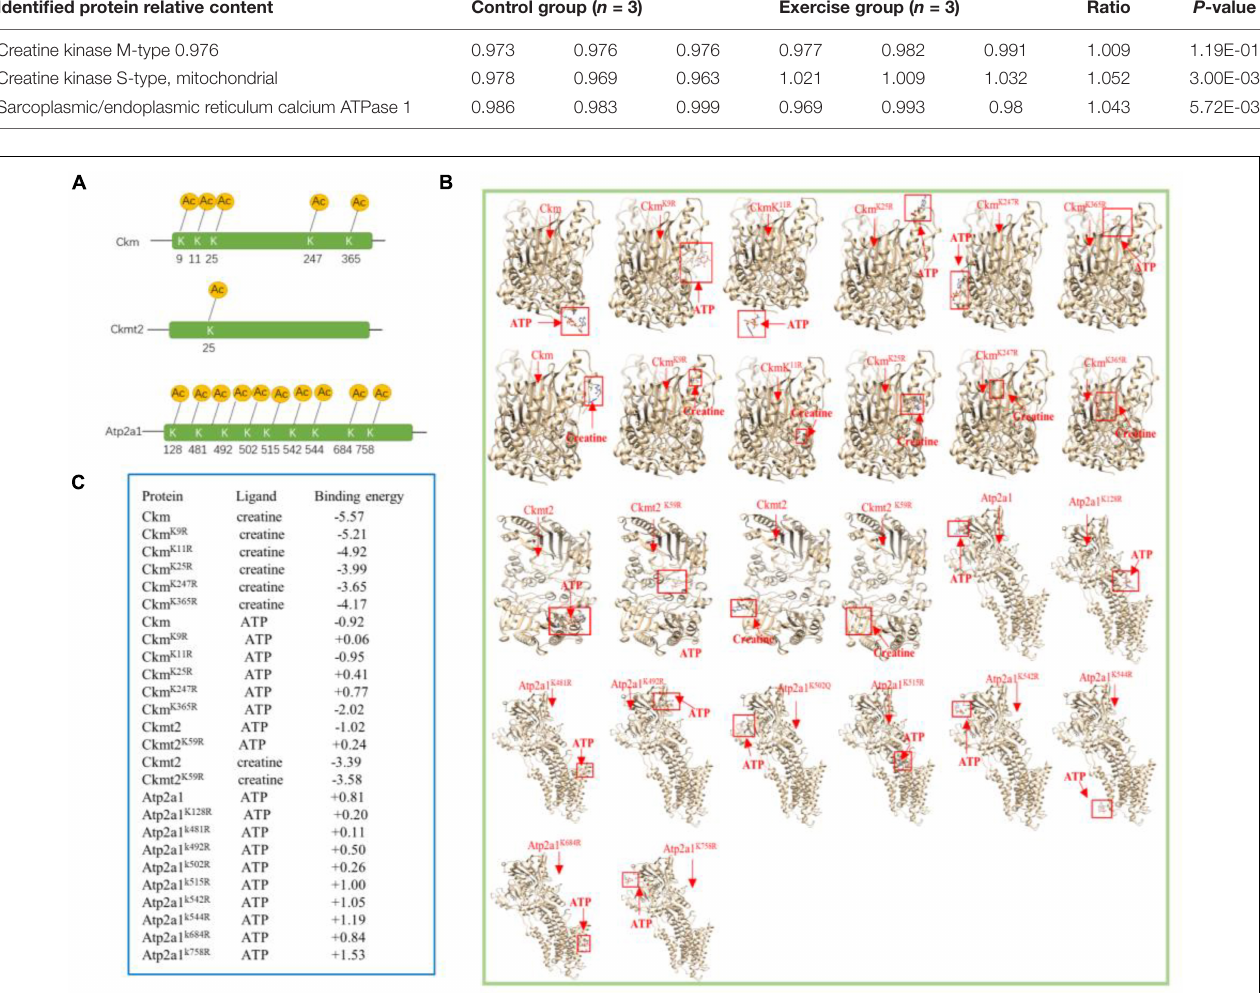
FIGURE 5 | Molecular docking analysis of enzymes. (A) Localizations of the multiacetylated sites in three enzymes that were identified with 5, 1, and 9 acetylated lysine residues. (B) AutoDock 4.2 was used to predict docking interactions of proteins and ligands. The binding positions are highlighted by red boxes. Ckm and Ckmt2 both have two ligands, and Atp2a1 has one ligand. (C) Docking results of the three enzymes.